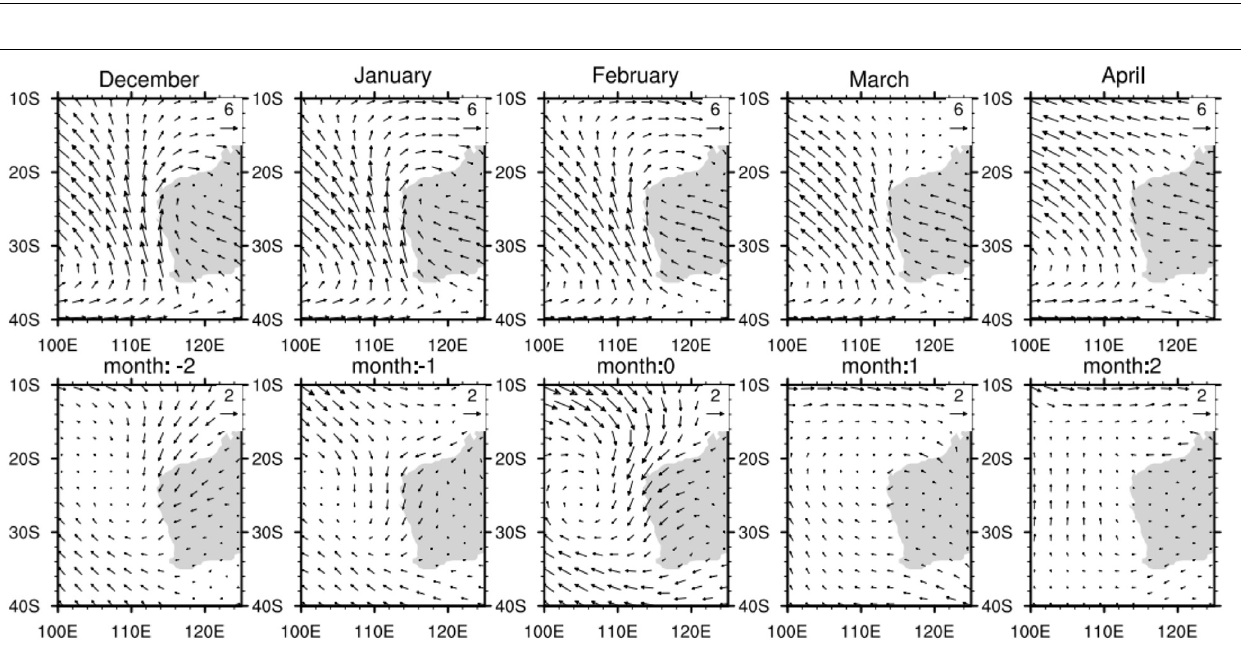
FIGURE 8 | Upper panels: Climatological monthly surface winds. Lower panels: Composite of surface wind anomalies (m/s) for Ningaloo Niño years. Surface winds from ERA-Interim are used for the analysis.